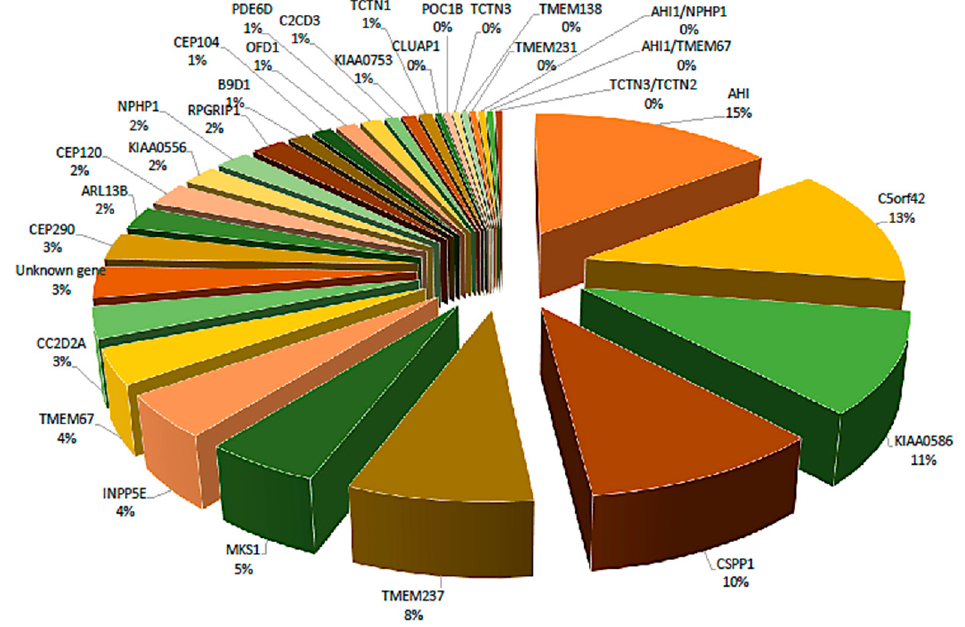
Figure 2. Proportion of mutations in different genes based on 245 patients with Joubert syndrome. Mutations were observed in 28 genes, but approximately half of the mutations were found in only four genes: AHI (15%), C5orf42 (13%), KIAA0586 (11%), CSPP1 (10%).